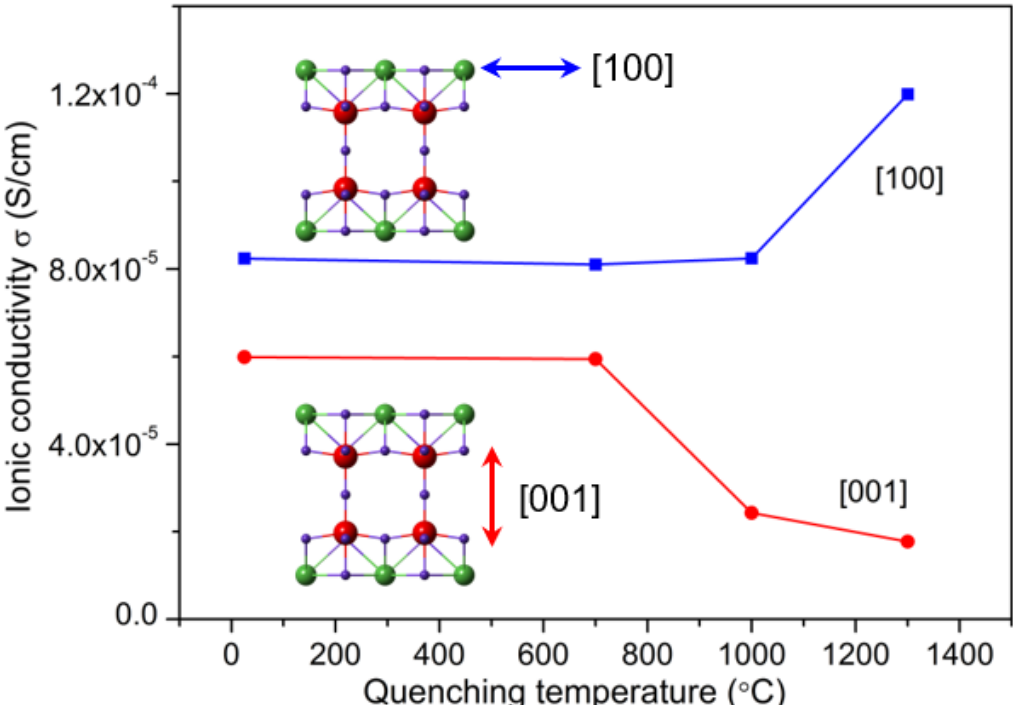
Figure 7. The anisotropic change of the ionic conductivity with the increasing quenching temperature. The in-A 1 -plane conductivity (in [100] direction) increases due to the La A1 → La A2 transition, forming more vacancies and space for ionic diffusion. As a result, the presence of La A2 and other intermediate defects block the out-of-A 1 -plane pathway (in [001] direction).